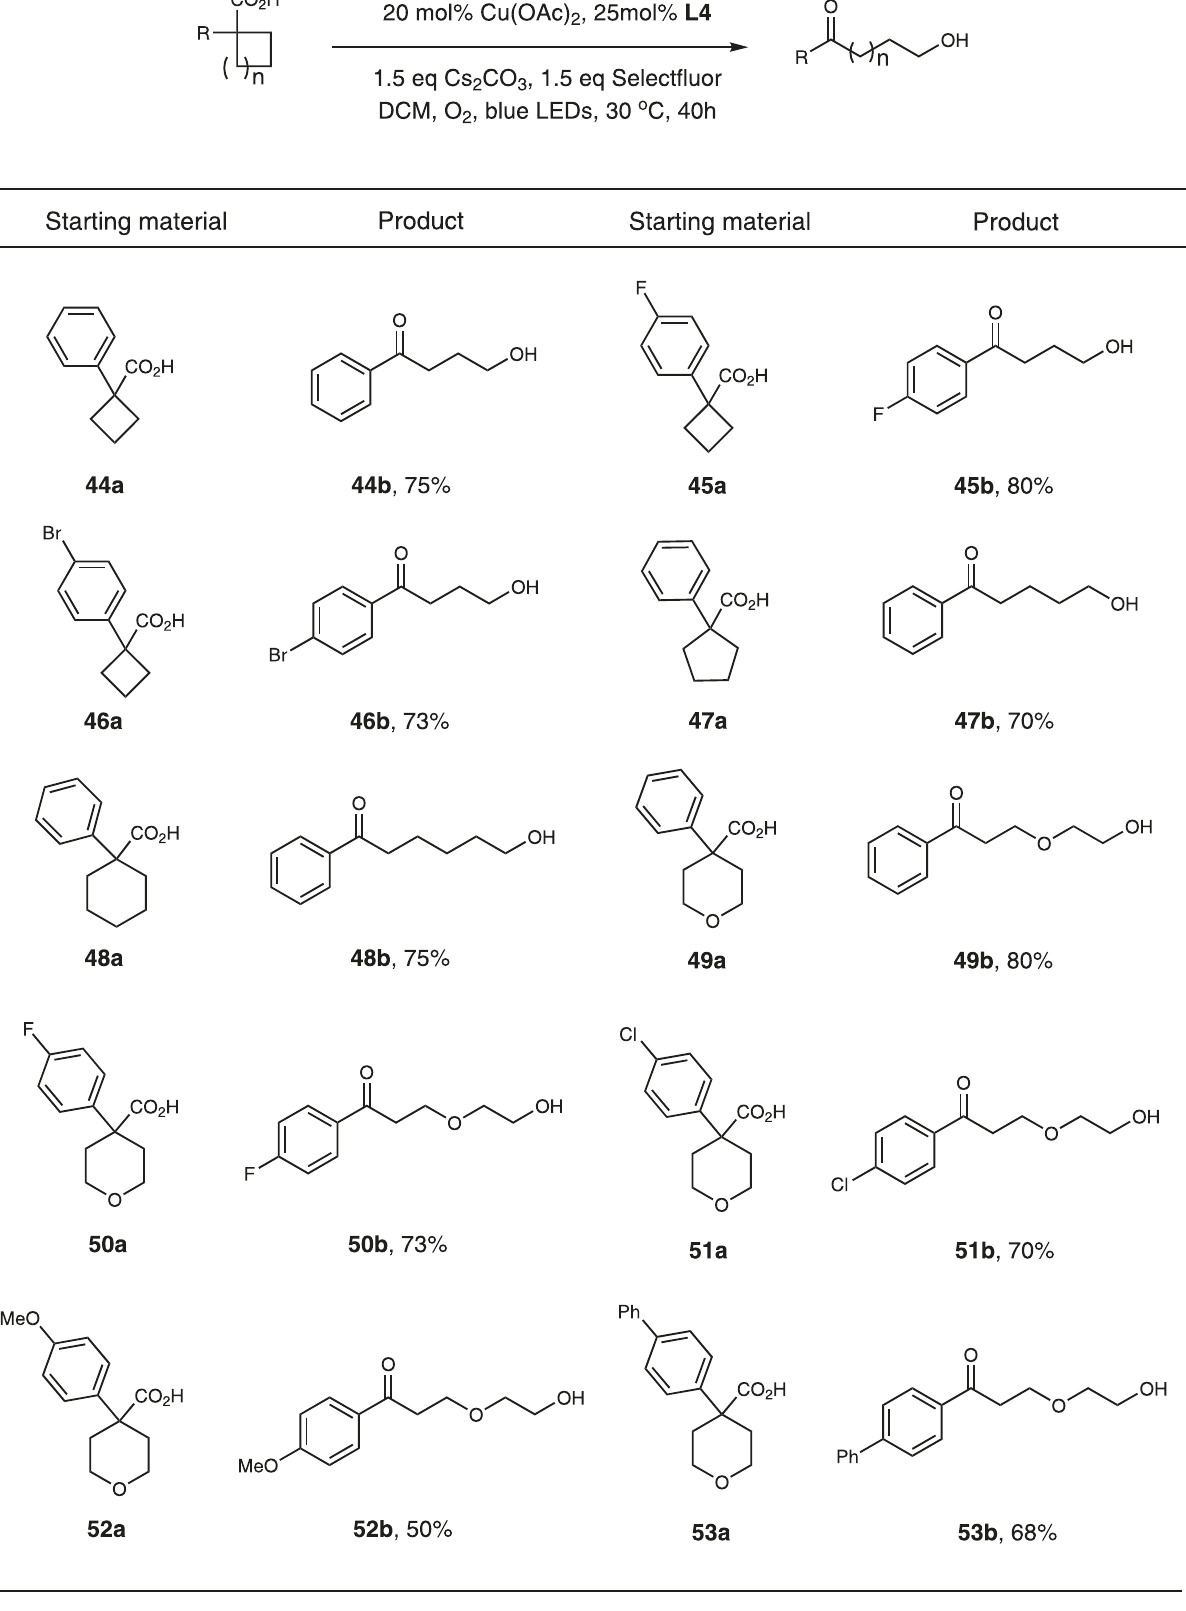
Fig. 6 | Substrate scope for the ketone-alcohol products. Reaction conditions: substrate (0.5mmol), Ir-1 (0.015mmol), Cu(OAc) 2 (0.1mmol), L4 (0.125mmol), Cs 2 CO 3 (0.75mmol), Select fl uor (0.75mmol), DCM (10mL), 45W blue LEDs, 30°C, 72h. Yields were determined by 1 H